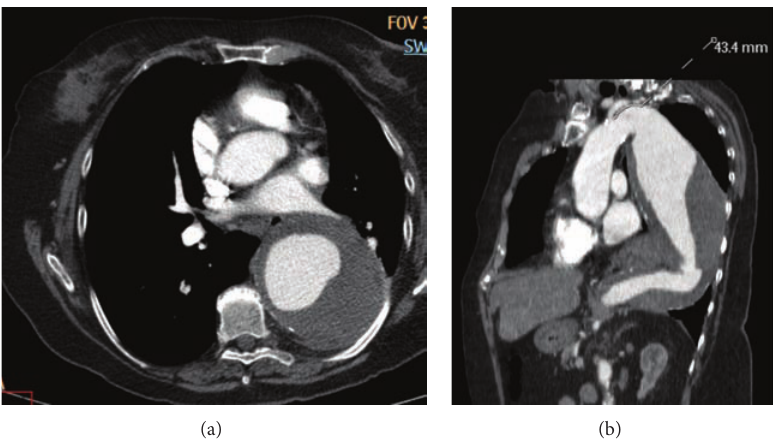
Figure 8: Descending thoracic aortic aneurysm—(a) axial CT scan image shows a large aneurysm of the descending thoracic aorta, with large intraluminal thrombus. (b) Oblique reconstructed CT image shows a large fusiform descending thoracic aortic aneurysm. There is a 4.3 cm distance between the neck of the fusiform aneurysm and the left subclavian artery, which makes this patient suitable for endovascular repair.